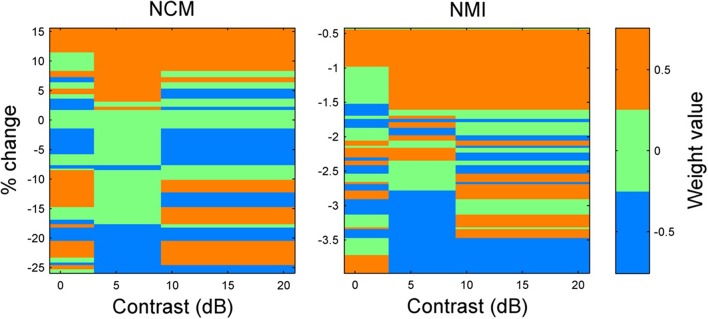
Results of weights applied to low, intermediate, and high contrast bands. Weights were applied to low, intermediate, and high contrast bands for 10 sentences with 5 dB additive white noise. The sorted averages of 10 sentences for the 27 weighting conditions are shown. The rows are centered on the actual value on the vertical axis and the row heights have been scaled to split the distance between successive weighting conditions. The worst NCM and NMI scores were obtained when performing simultaneous compression of intermediate and high contrasts. Importantly, any enhancement of low contrasts or high contrasts when intermediate contrasts were not also enhanced, lowered the NCM score. Furthermore, any compression of intermediate contrasts lowered the NCM score. The optimal weighting scheme for both the NCM and NMI scores (ignoring the case of no weighting for the NMI) is uniform enhancement.